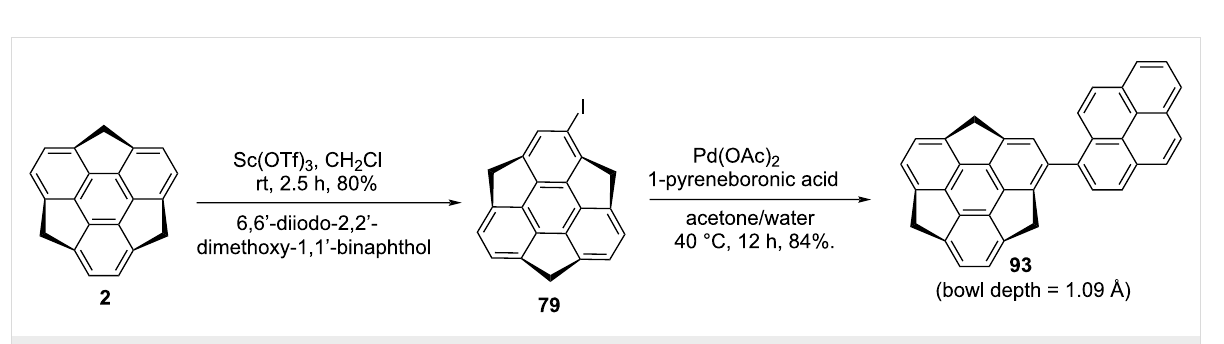
Scheme 22: Pyrenylsumanene 93 involving the Suzuki-coupling as a key